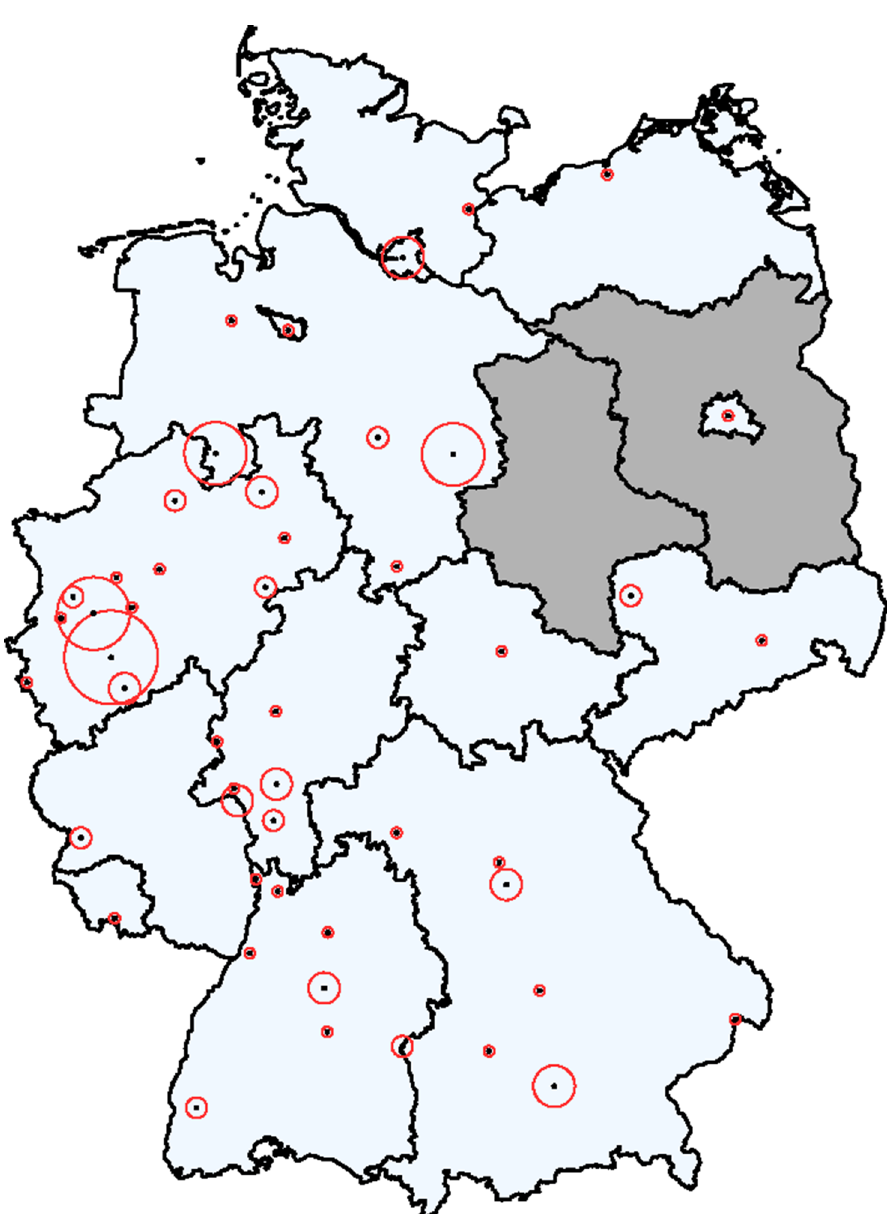
Figure 1: Sensor locations in Germany